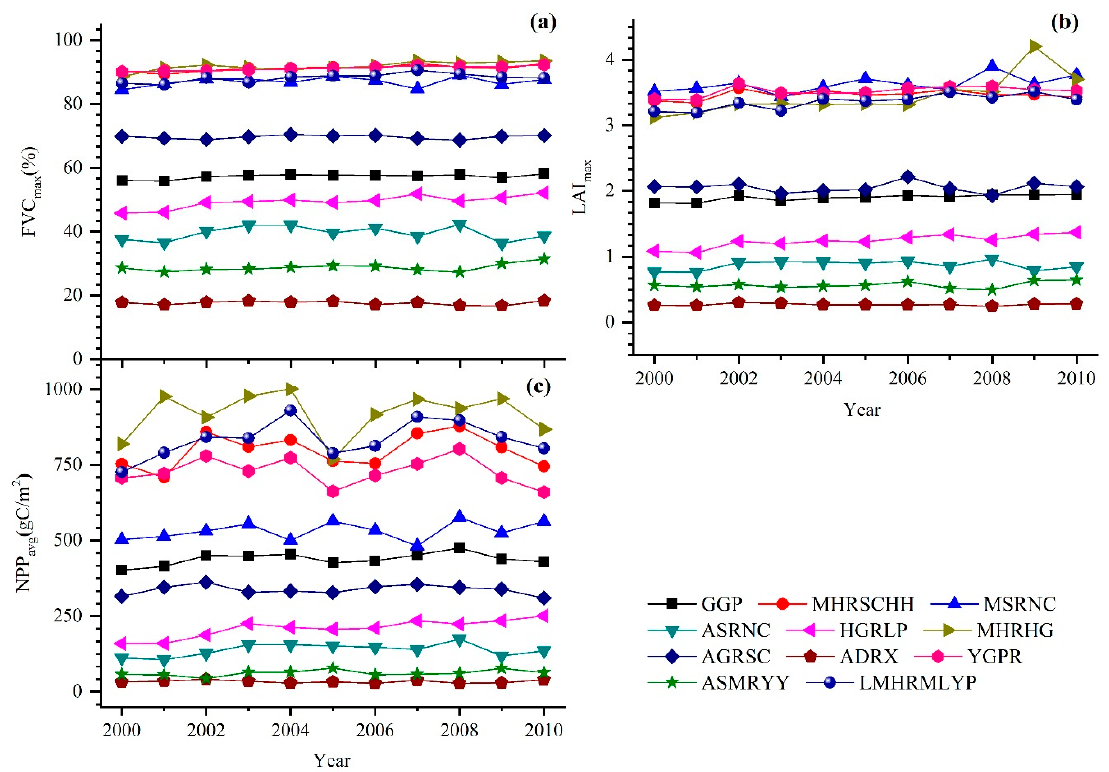
Figure 5. Temporal trends of annual ecosystem quality (EQ) changes in the Grain for Green Program (GGP) area from 2000 to 2010. ( a ), ( b ), and ( c ) are the temporal trends of annual FVC max , LAI max , and NPP avg changes, respectively.